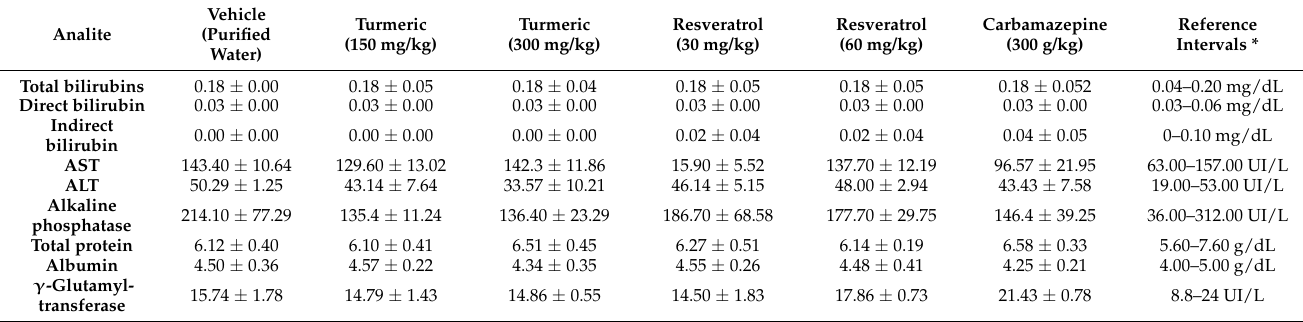
Table 2. Post-status epilepticus hepatic function tests of rats treated with the vehicle, turmeric, resveratrol, or carbamazepine.